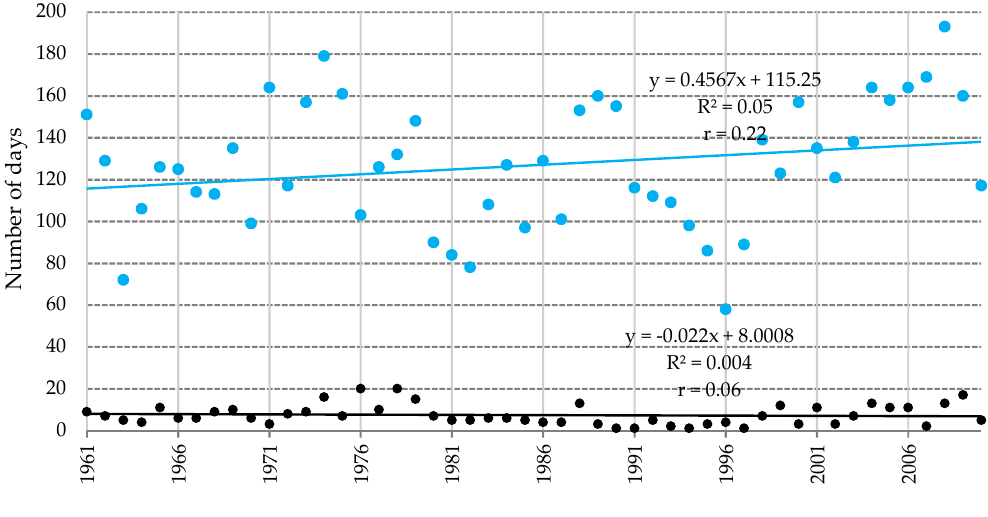
Figure 9. Trend in the number of days with hydrometeorological conditions potentially favorable to initiation and particularly conducive to intensification of aeolian processes in the Polish Baltic coastal zone.